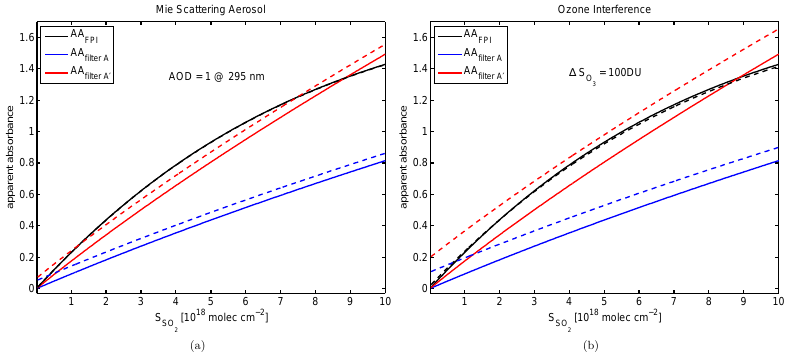
due to 2 = 100DU was assumed. Again, the FPI measurement shows far less 3